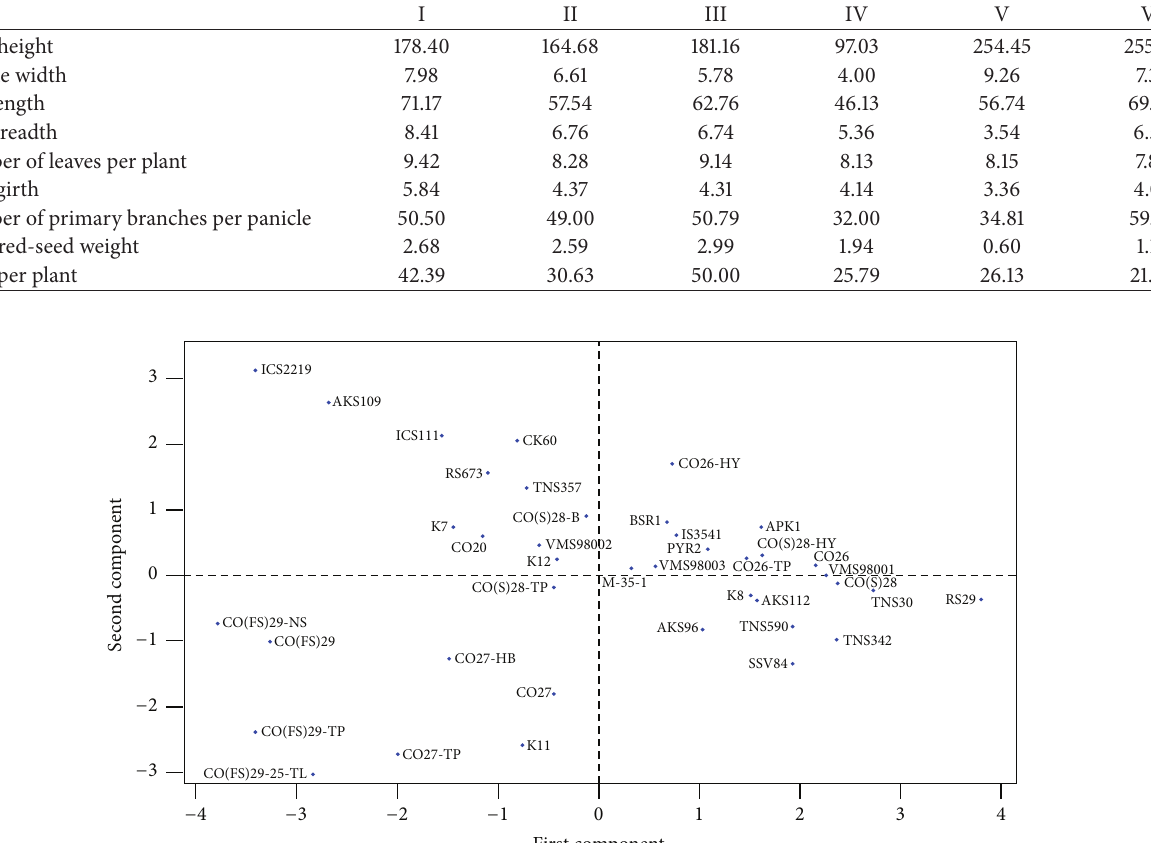
Table 7: Characteristic means of six similarity cluster groups of sorghum accessions.